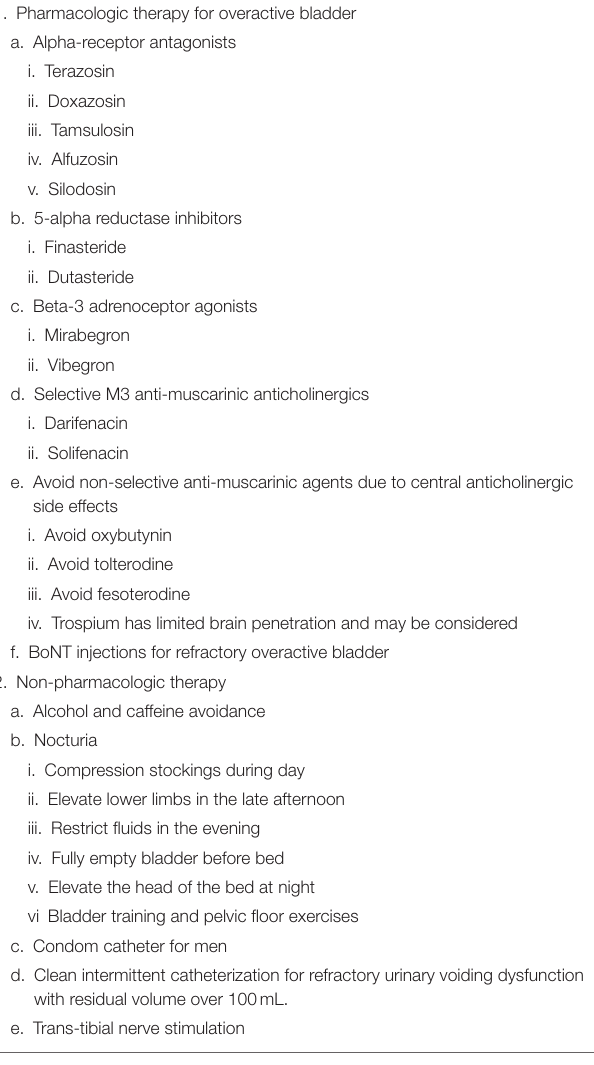
TABLE 6 | Management of urinary dysfunction in